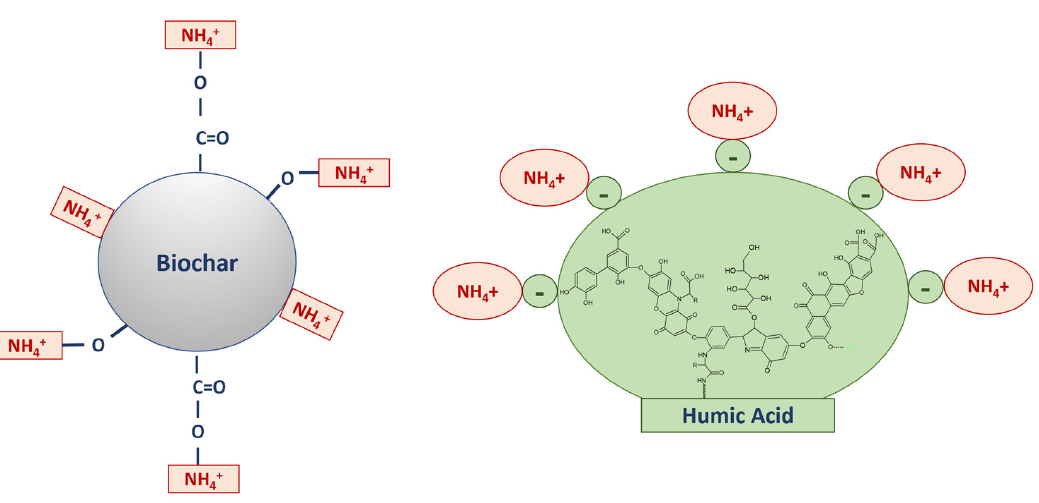
Figure 4. Ion binder–ammonium ion interactions are used to stabilize ammonium carbonate materials. Compiled from [47,48].